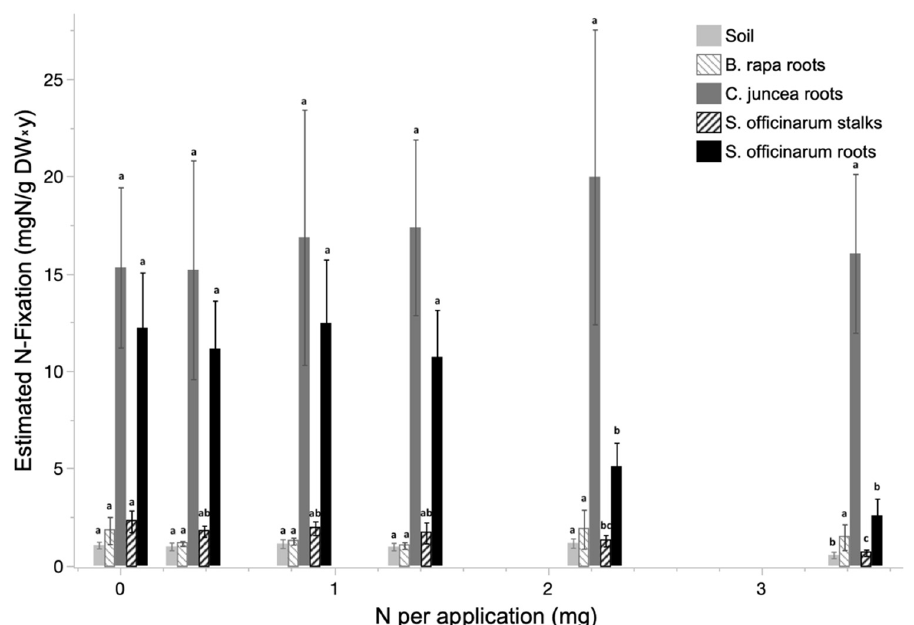
Figure 4. Estimated mean annual N fixation and associated standard error extrapolated from acetylene reduction assay (ARA) for sugarcane, the soilless media, and the N-fixing and non-N-fixing control plants, conducted at terminal harvest of the experiement. The connecting letters represent Tukey’s HSD test for each subject across treatments. The x -axis is the main treatment of nitrogen application per plant per fertilization.